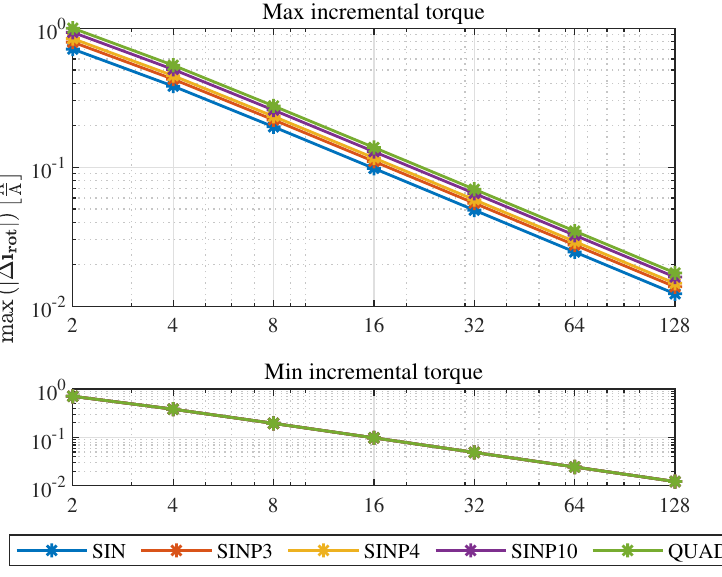
Figure 10. Maximum and minimum incremental torque for different signal shapes and microstepping resolutions. Quadrature microstepping with resolution x2 is equivalent to half step movement.